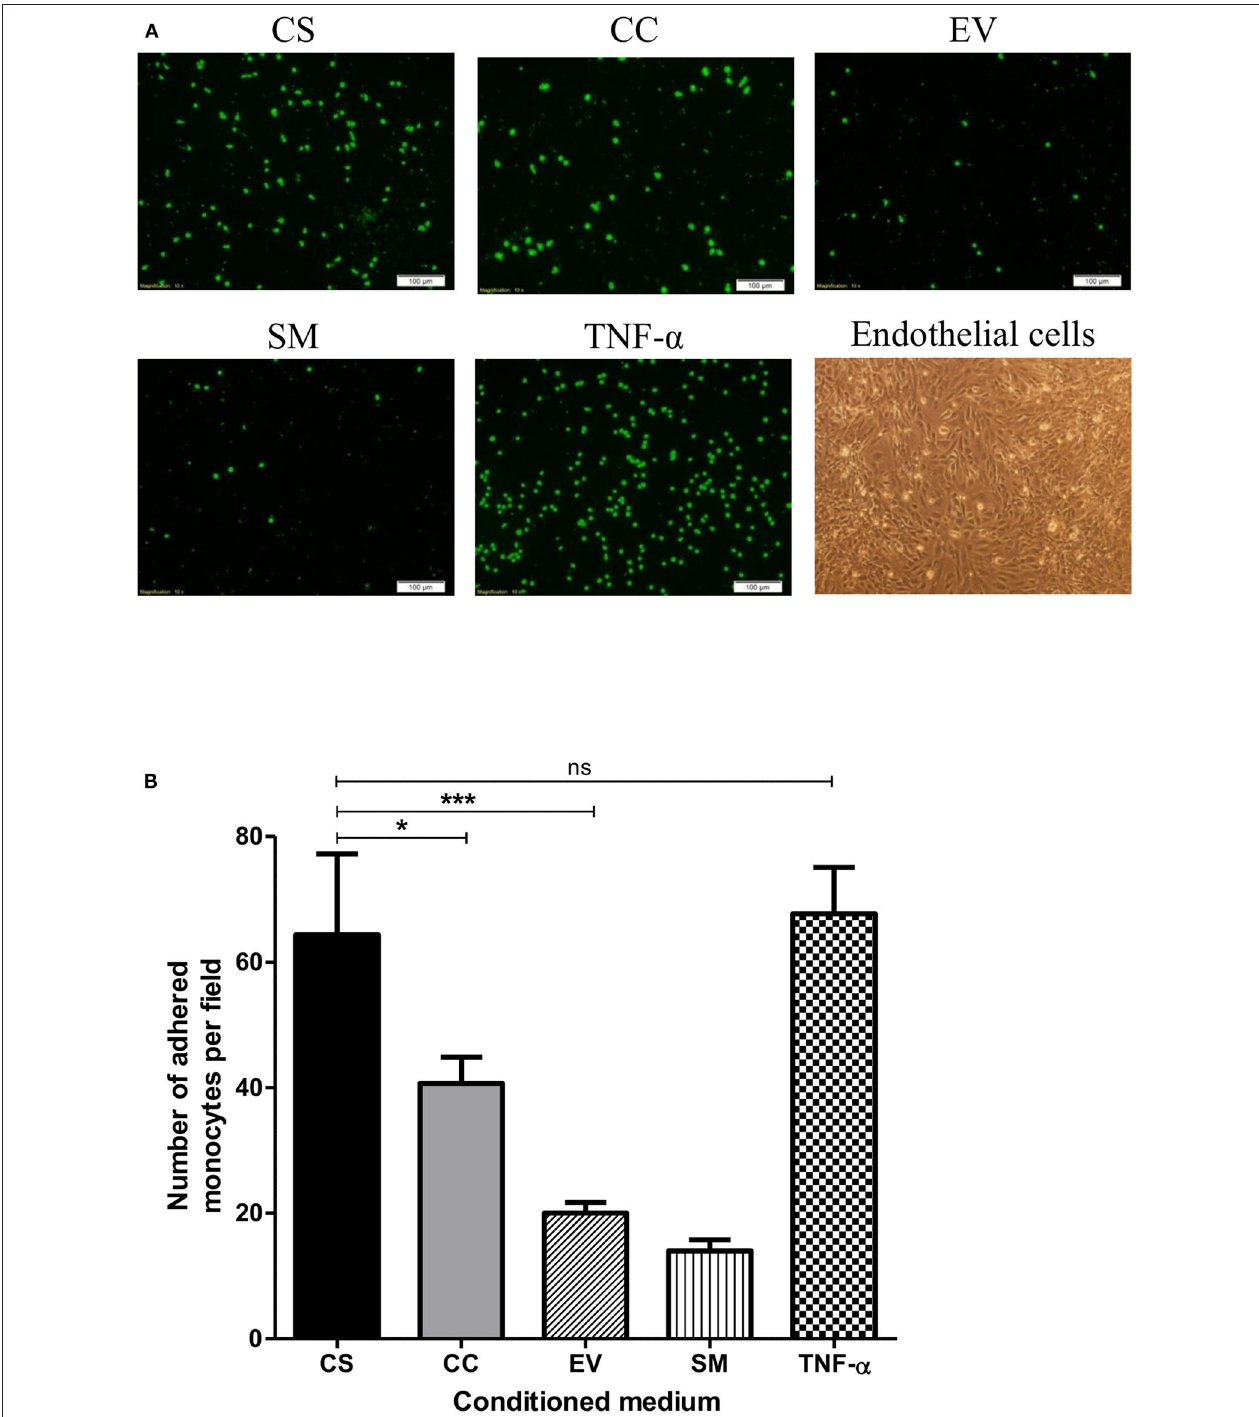
FIGURE 7 | The treatment with CS-Tat Jurkat-conditioned medium augments monocyte-endothelial cell adhesion. hCMEC/D3 endothelial cells were grown to confluence on collagen-coated coverslips in 24-well plates. Following 12h of serum starvation, the monolayer was exposed to Jurkat-Tat-conditioned media for 24h. In parallel, THP1 cells were treated with the Jurkat-Tat conditioned media for 12h, washed, and labeled with CalceinAM. The CalceinAM-labeled THP1 cell suspension was added to the endothelial monolayer, and following 10h of the addition of THP1 cells, the coverslips containing the endothelial monolayer were washed with HBSS. (A) The adhered THP1 cells under each treatment were imaged using a fluorescent microscope. Endothelial cells treated with RPMI supplemented with 10% FBS served as the background control (SM) and cells treated with 10ng/ml of TNF- α served as the positive control in the assay. (B) Five fields per treatment were used for the quantification, and the number of adhered monocytes per field were counted using ImageJ. The mean numbers of cells per field ± SD were plotted for each treatment. The assay was repeated twice, one-way ANOVA with Tukey–Kramer post-test (* p < 0.05, *** p < 0.001 and ns, non-significant).